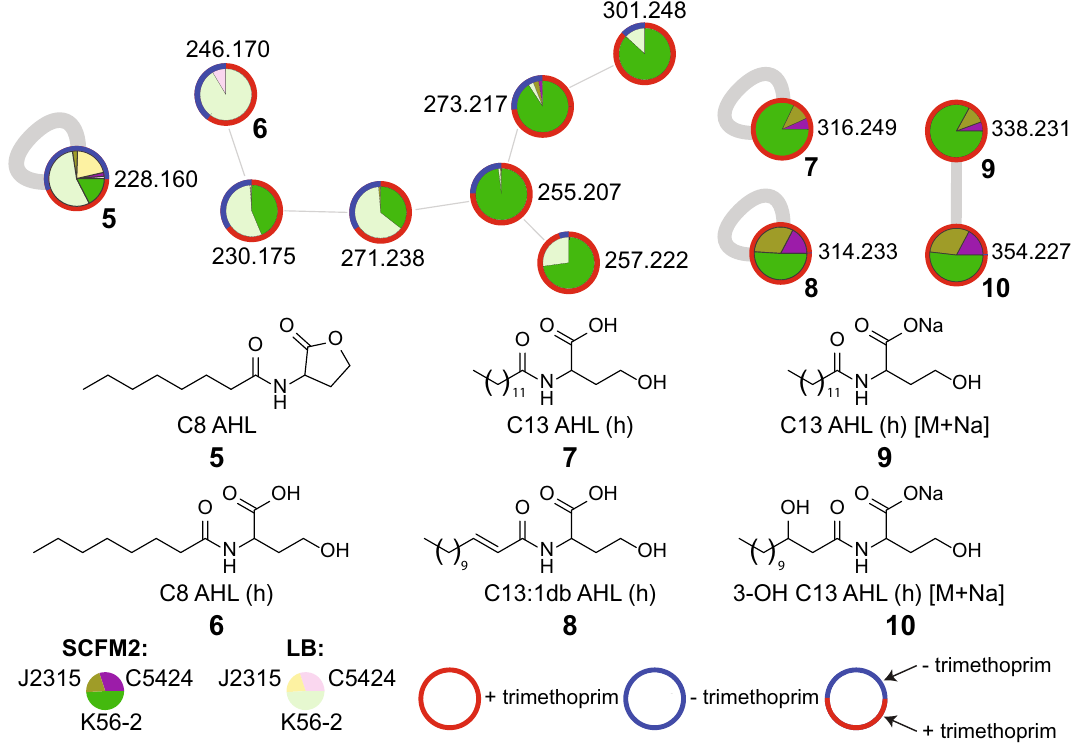
Figure 4. Distribution of N -acyl-homoserine lactones (AHL) and their hydrolyzed forms detected across three B. cenocepacia strains in both LB and SCFM2 media. Pie charts on nodes correspond to relative abundance in strain and media condition. The coloring of node border represents whether the metabolite was detected only in the presence of trimethoprim (red border), only in the absence of trimethoprim (blue), or both in the presence or absence of trimethoprim (mixed color). A combination of blue and red border color shows total relative abundance of the metabolite in the absence or presence of trimethoprim, respectively across all strains. The structures for C8-AHL ( 5 ), hydrolyzed C8-AHL ( 6 ), hydrolyzed C13-AHL ( 7 ), and hydrolyzed C13:1db-AHL ( 8 ) as well as sodium adducts of hydrolyzed C13-AHL ( 9 ) and hydrolyzed 3-OH-C13-AHL are shown ( 10